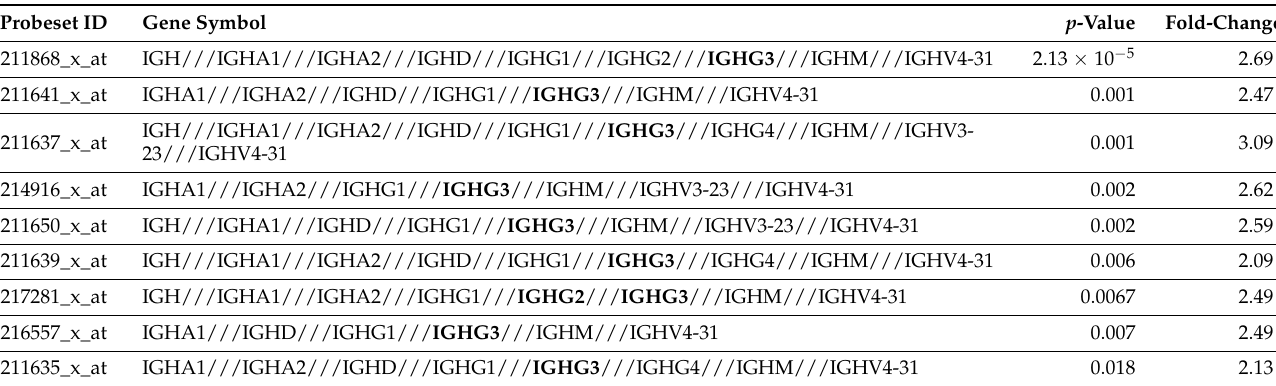
Table 3. Analysis of antigen transcription in 100 CRC patients compared with five normal donors using publicly available RNA-seq data. Nine probesets, each including IGHG2 and IGHG3, had >2-fold increased transcription of the heavy chain constant regions of IgG2 and IgG3 in tumour versus normal